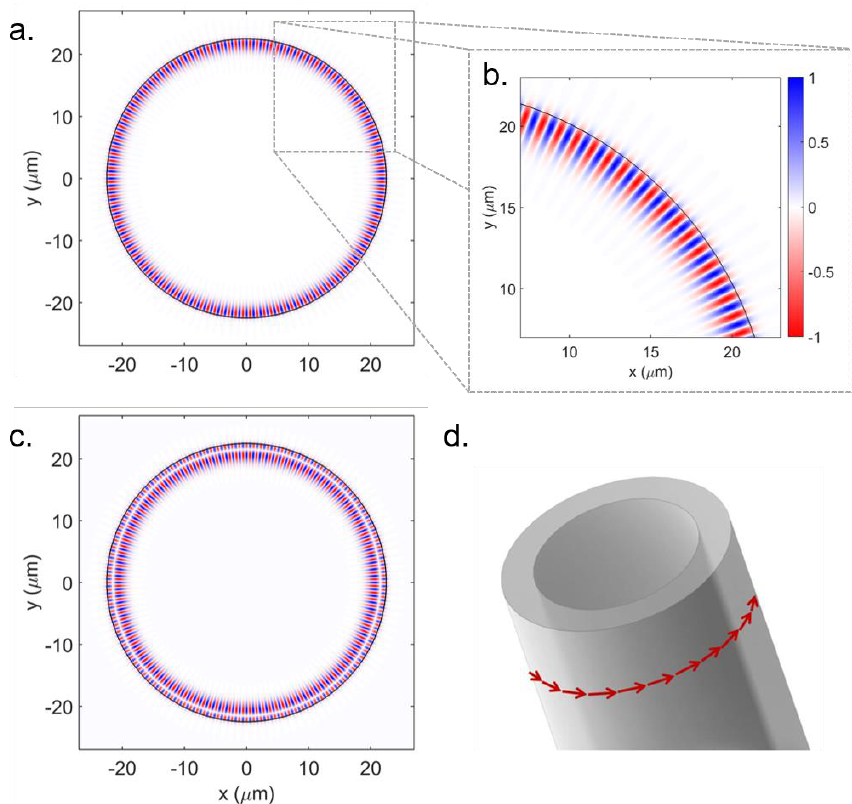
Figure 11. 𝐸 𝑧 field amplitude over a transverse plane of the cylinder for the azimuthal order m = 120 and the following radial orders: ( a , b ) 𝑙 = 1 ( 𝜆 120,1 = 1668.2 nm) and ( c ) 𝑙 = 2 ( 𝜆 120,2 = 1579 nm). Item ( b ) shows a zoomed-in view of the field distribution displayed in ( a ), along with the color bar for all the field distributions. The circumference corresponds to the cylinder’s edge. To obtain these field profiles, the refractive indices of both media and microcylinder’s radius were set to 𝑛 1 = 1.51 , 𝑛 2 = 1.0 and 𝑎 = 22.5 µm in Equation (9). ( d ) Geometric Optics picture of the WGMs propagating along the rim of a microcylinder. Adapted with permission [40]. Licensed under a Creative Commons